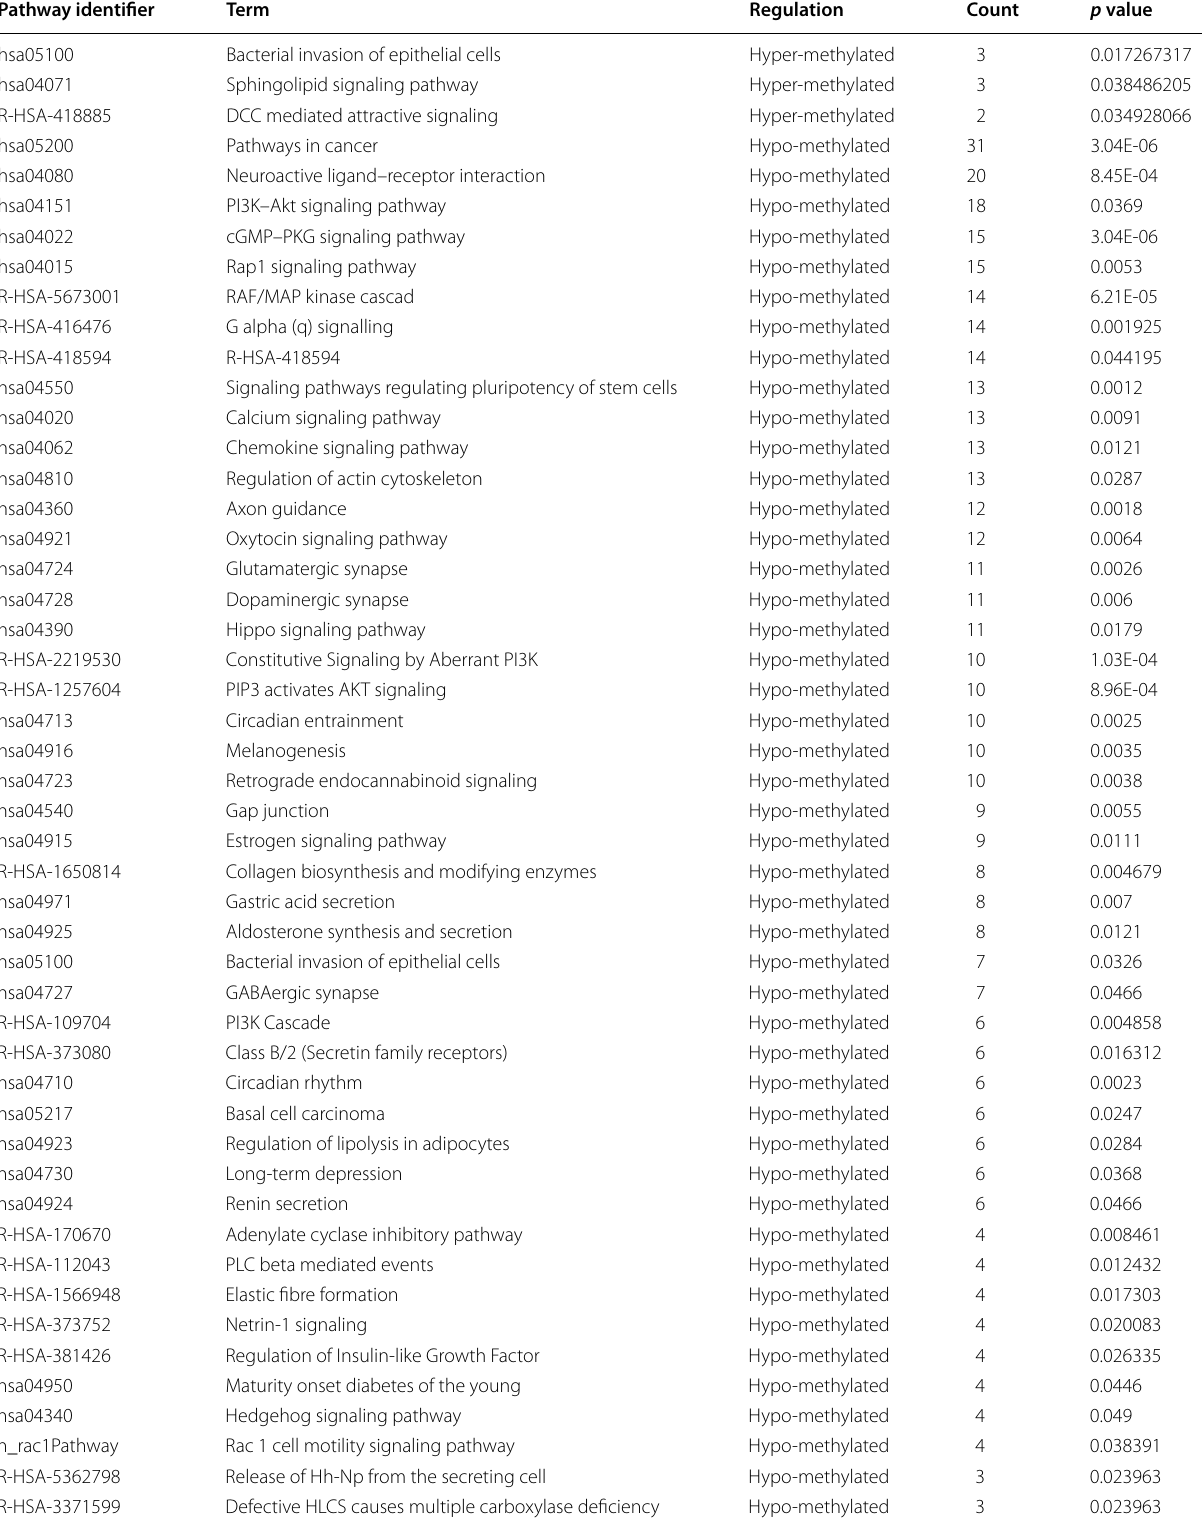
Table 4 Signaling pathway enrichment analysis of DMGs in periodontitis